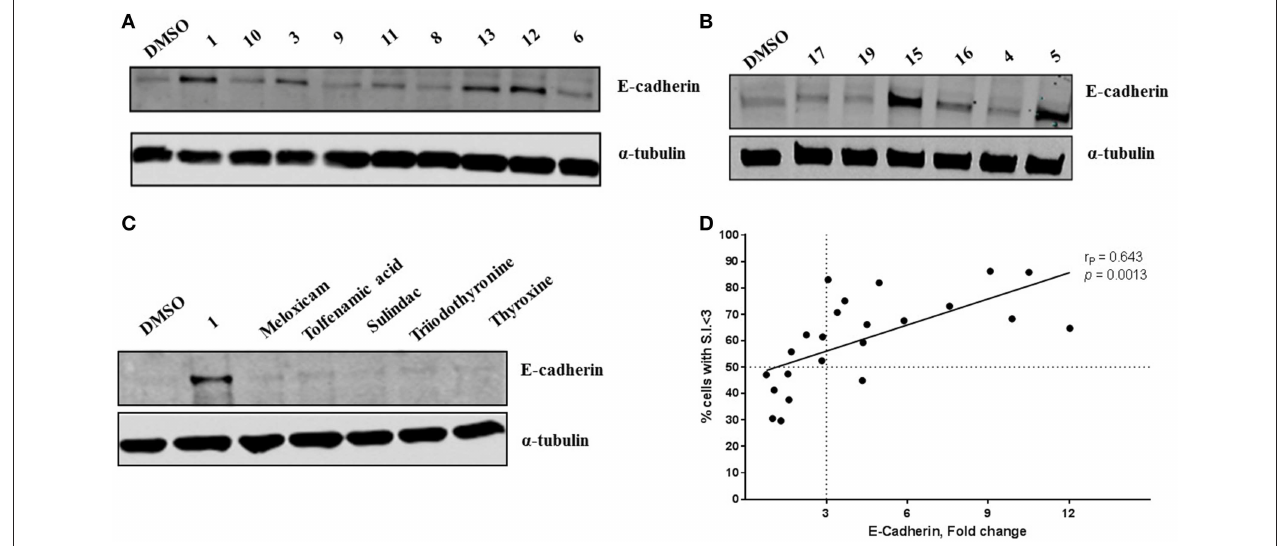
FIGURE 3 | Novel diphenylamine analogs induce E-Cadherin protein expression in MDA-MB-231 cells (A,B) . Western blot images of MDA-MB-231 cells treated with novel diphenylamine compounds at 1 µ M concentration for 5 days. E-Cadherin protein expression is normalized to α -tubulin and the data are summarized in Table 1 . (C) E-Cadherin expression after treatment with NSAIDs and thyroid hormones in MDA-MB-231 cells (5 days treatment at 1 µ M concentration). (D) Increase in E-cadherin expression significantly correlates with the percentage of cells that exhibit a phenotypic switch. A positive correlation between E-Cadherin protein expression, compared to DMSO and an increase in percentage of cells with S.I < 3 was observed. Data was analyzed by two-tailed Pearson correlation. The correlation coefficient (rP) and significance ( p -value) are indicated on the scatter plot.